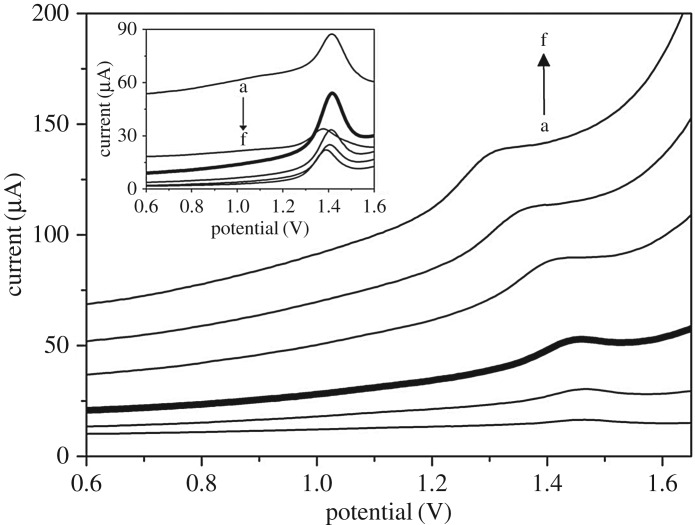
DPV records of 0.44 mM CAF in 0.1 M H2SO4 on GCE for various pulse potentials: (a) 10, (b) 25, (c) 50, (d) 100, (e) 150 and (f) 200 mV. The optimization of pulse time: (a) 5, (b) 10, (c) 25, (d) 50, (e) 100 and (f) 150 ms appears in the inset.